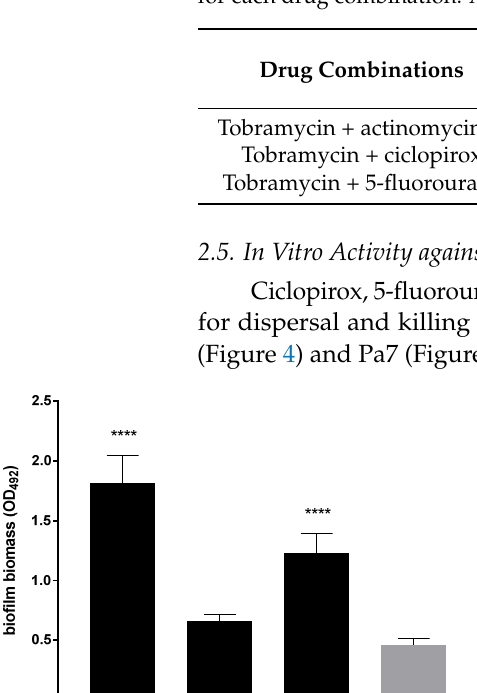
Table 4. Activity of tobramycin in combination with other “non-antibiotic” drugs. The fractional inhibitory concentration index (FICi) was calculated as follows, using the checkerboard assay: FIC A + FIC B , where FIC A = MIC of drug A in combination/MIC of drug A alone, and FIC B = MIC of drug B in combination/MIC of drug B alone. The best FICi value and the range of FICi values were reported for each drug combination. All FICi values obtained indicated an additive effect (0.5 < FICi ≤ 4) [25].